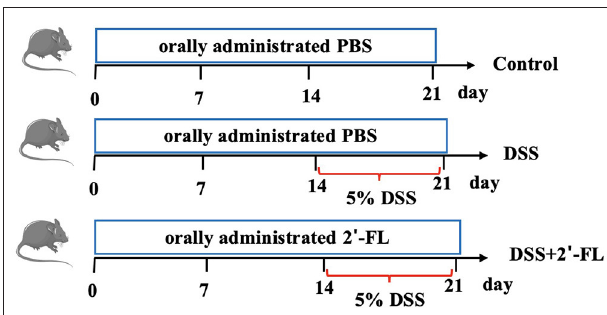
FIGURE 1 | Experimental workflow for evaluating the effects of 2 ′ -fucosyllactose (2 ′ -FL) on colitis.